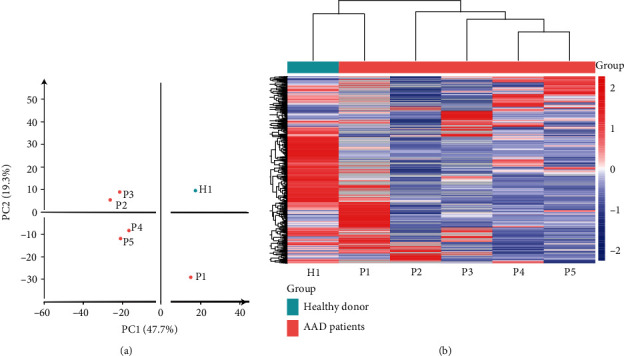
Principal component analysis (PCA) and heat map of proteome data. (a) Principal component analysis of the proteome data in a 2D graph of PC1 and PC2. (b) Expression heat map of the proteome data in the samples.